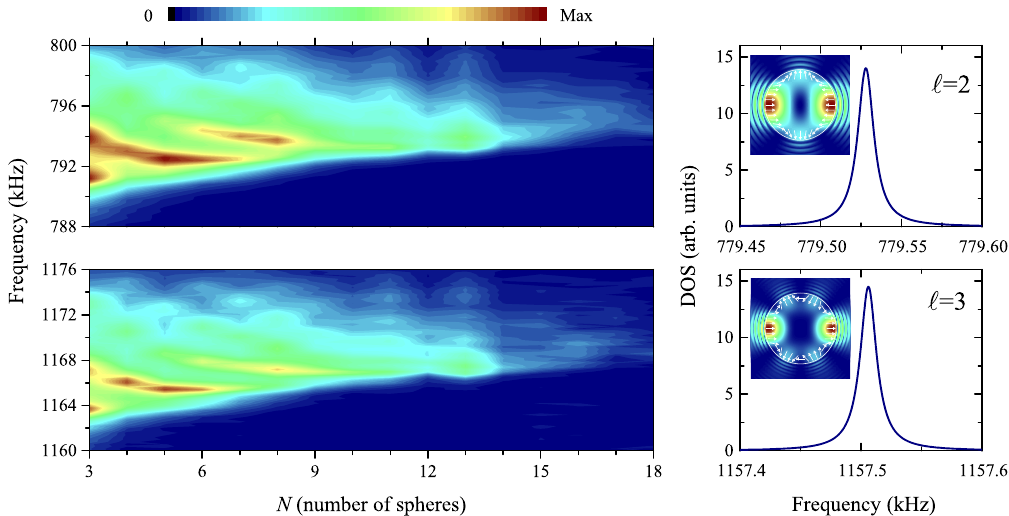
Figure 10. (left) : color map of the transmitted displacement field measured at the end of a chain made of N D3N42 magnetic spheres ( d = 3 mm), as a function of frequency and number of spheres. Two narrow localized bands are observed, originating from (cid:96) = 2 ( top ) and (cid:96) = 3 ( bottom ) resonance modes of the individual sphere; (right) , the corresponding DOS calculations for one sphere, together with the elastic field on resonance, at a cut passing at the center of the sphere (incidence is considered from left to right